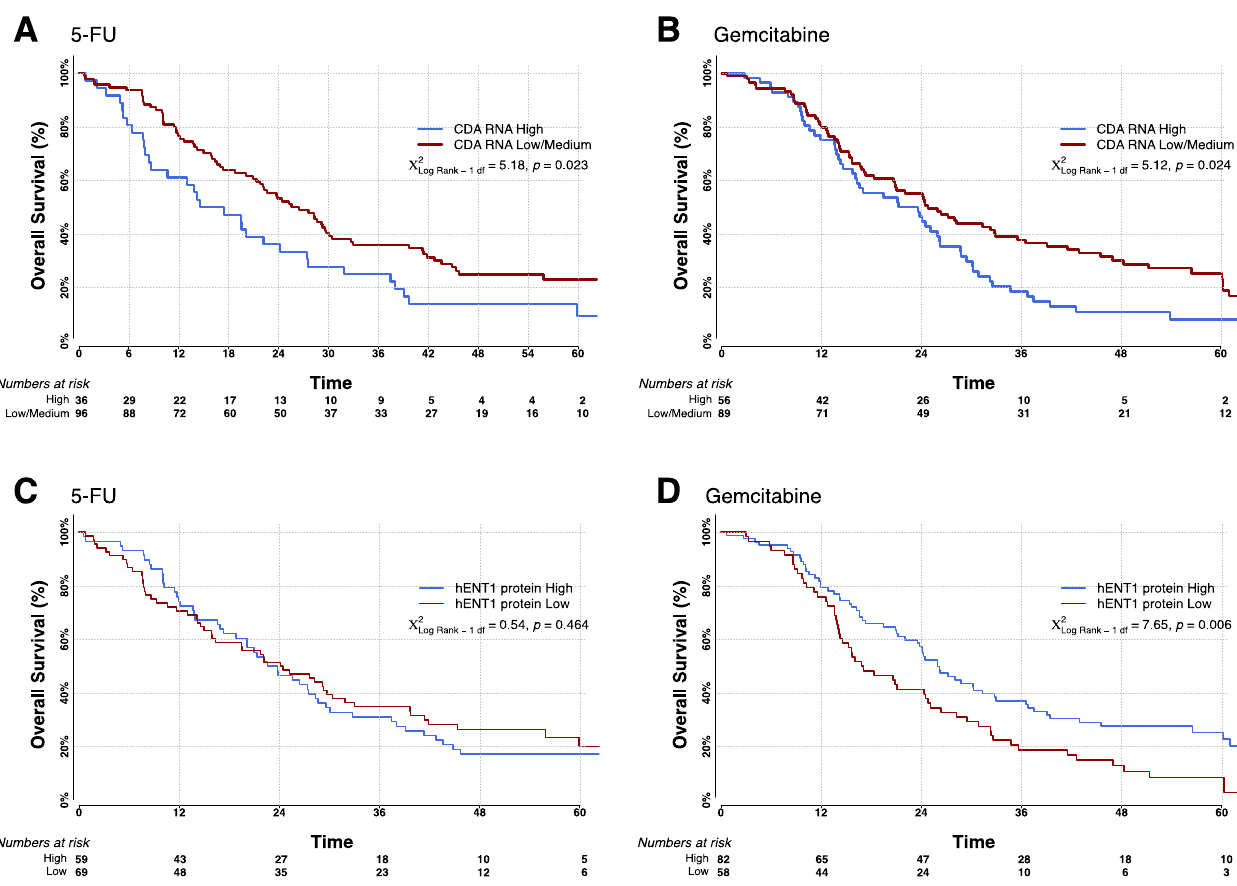
Figure 2. Kaplan-Meier survival curves separated by both treatment arms (5-FU and gemcitabine) and biomarker expression levels. ( A , B ): Survival curves for patients with low and high CDA mRNA levels (low ≤ 0.61, high > 0.61 MSPC), for patients randomized to adjuvant treatment with 5-FU ( A ) and gemcitabine ( B ). ( C , D ): Survival curves for low and high hENT1 expressing patients (low ≤ 48, high >48 H-Score), for patients randomized to adjuvant treatment with 5-FU ( C ) and gemcitabine ( D ). All groups and the number of at-risk individuals are shown in each graph. All p -values were determined by log-rank analyses using two-sided χ 2 tests.